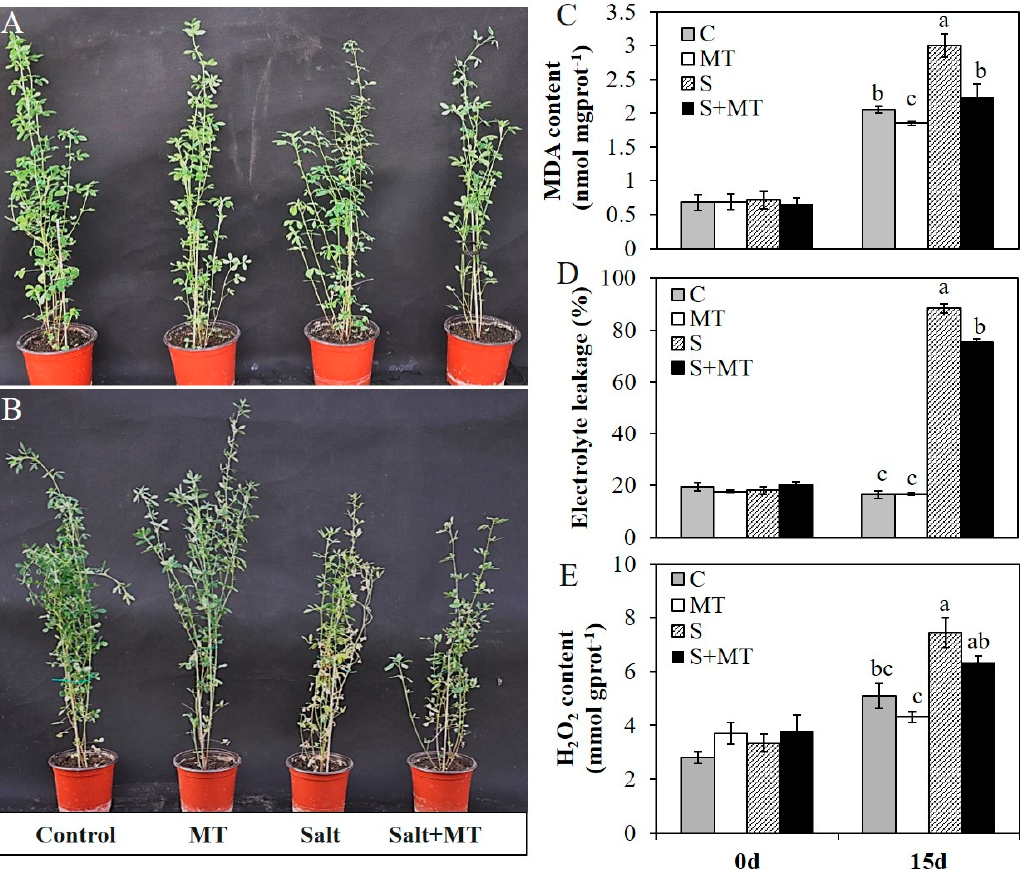
Figure 4. Effects of MT (50 µM) pretreatment on one-month-old alfalfa plants exposed to salt stress (200 mM NaCl) for 15 days. A, B, Plants sprayed with MT (50 µM) or water for 7 days ( A ) and subsequently subjected to salt stress with 200 mM NaCl or normal conditions for 15 days ( B ). Plants from left to right: plants grown under normal conditions, plants pretreated with MT and grown under normal conditions, plants subjected to salt stress, and plants pretreated with MT and then subjected to salt stress; C–E, Effects of MT pretreatment on the MDA content ( C ), electrolyte leakage ( D ) and H 2 O 2 content ( E ) of alfalfa plants before and after salinity treatment or under normal conditions. Data are represented as means ± SE ( n = 3), and bars with different letters indicate the differences between these four different groups according to ANOVA analysis ( p < 0.05).